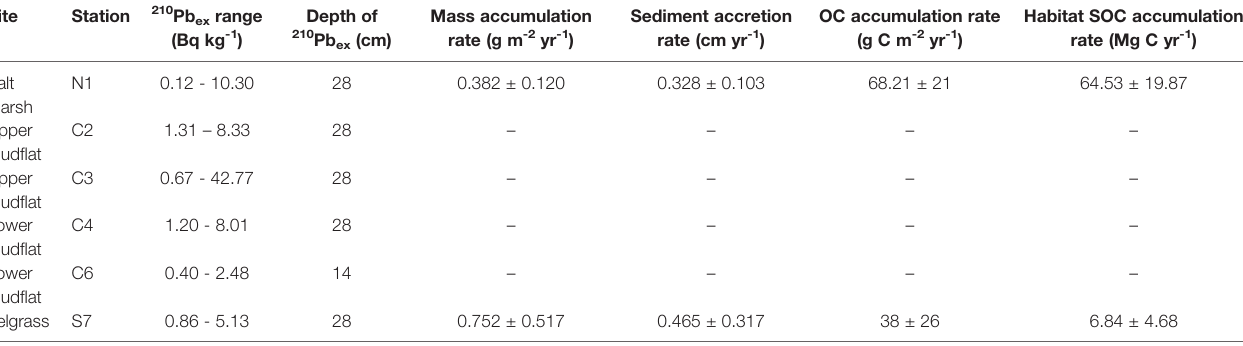
Table Legend: Means and Monte Carlo uncertainty are shown for each